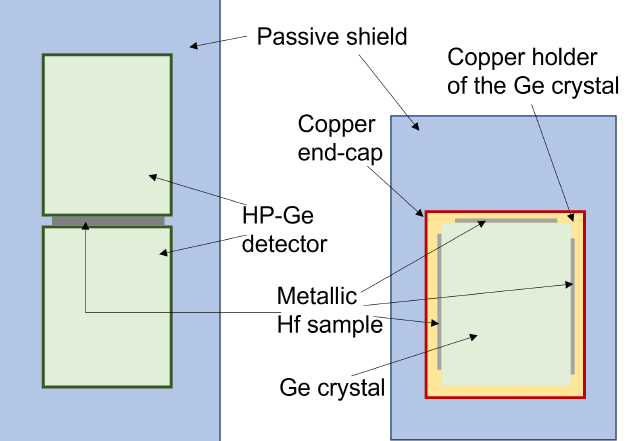
Figure 2. Simplified schematic representation of the experimental setups (not in scale) detailed in Refs. [29] (for the left scheme) and [30] (for the right